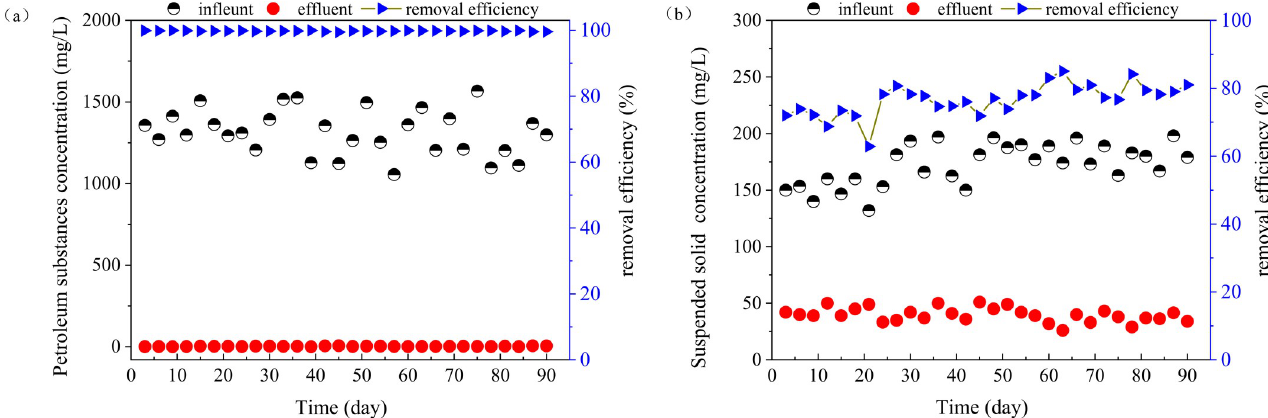
Fig 3. Removal efficiency of the ABR system for (a) Petroleum substances; and (b) suspended solids.